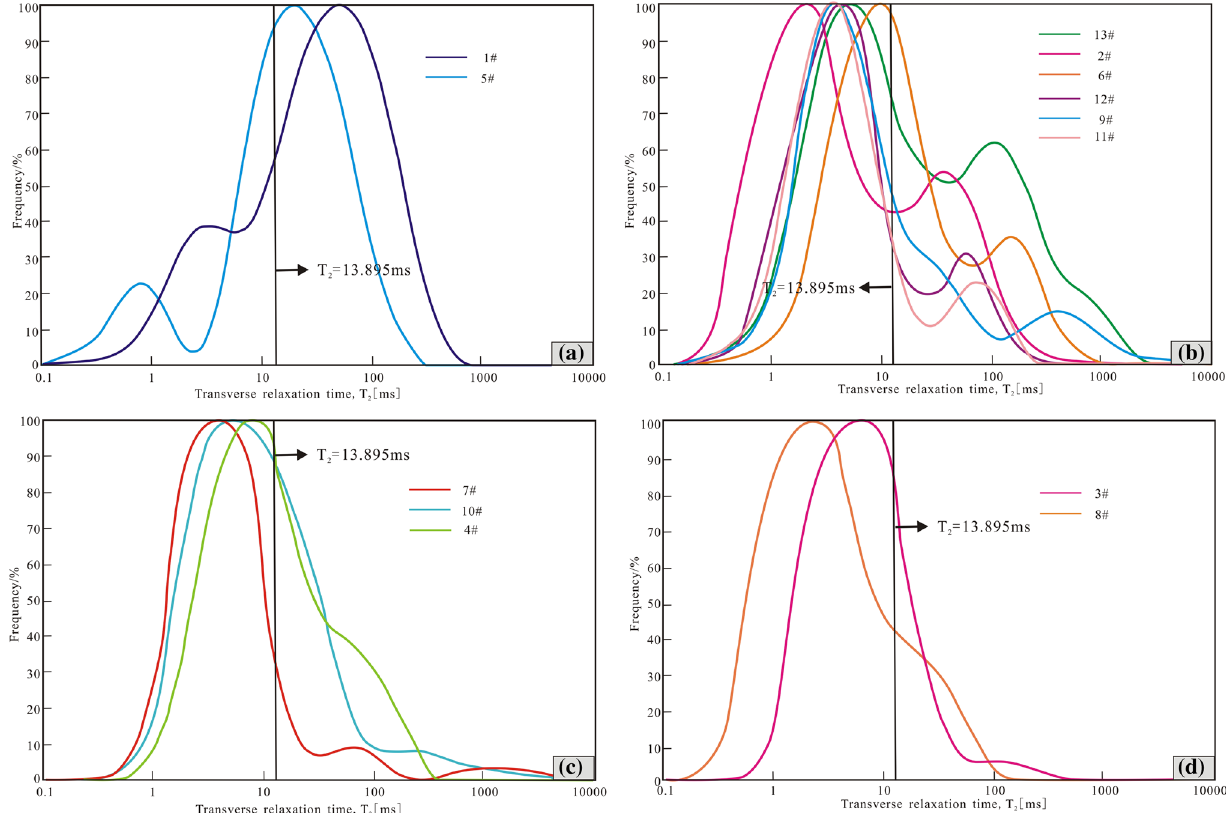
Fig. 2 T 2 spectra of Chang 8 1 reservoir in the Maling